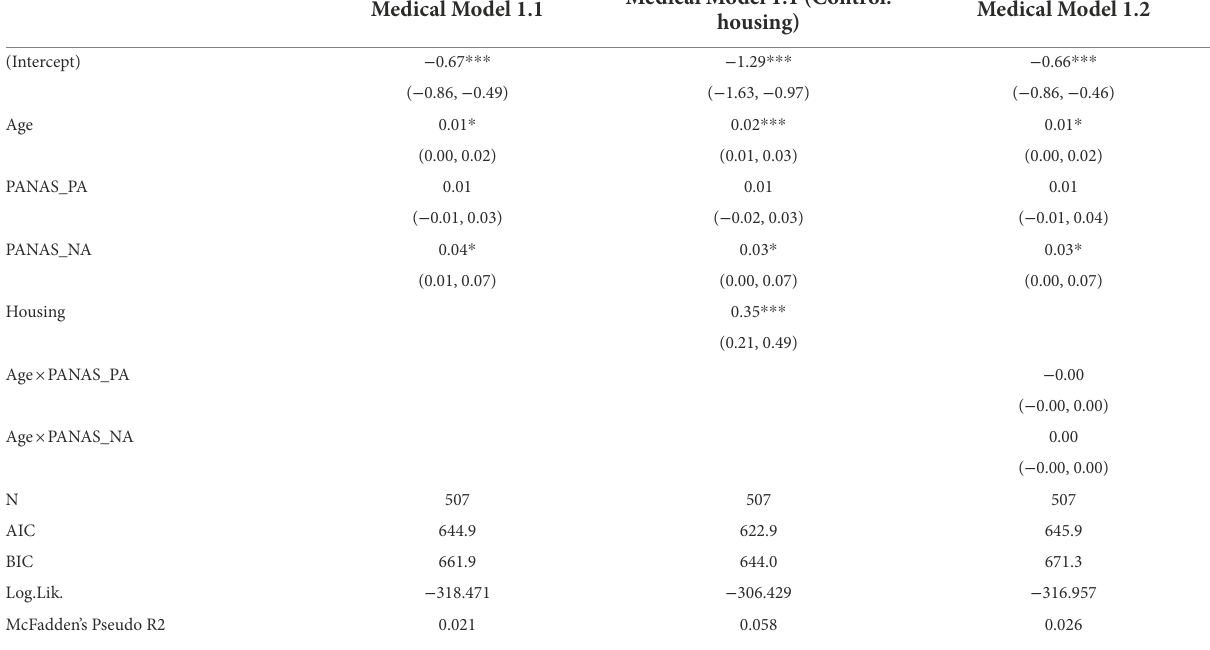
TABLE 6 Medical supply scarcity model (full